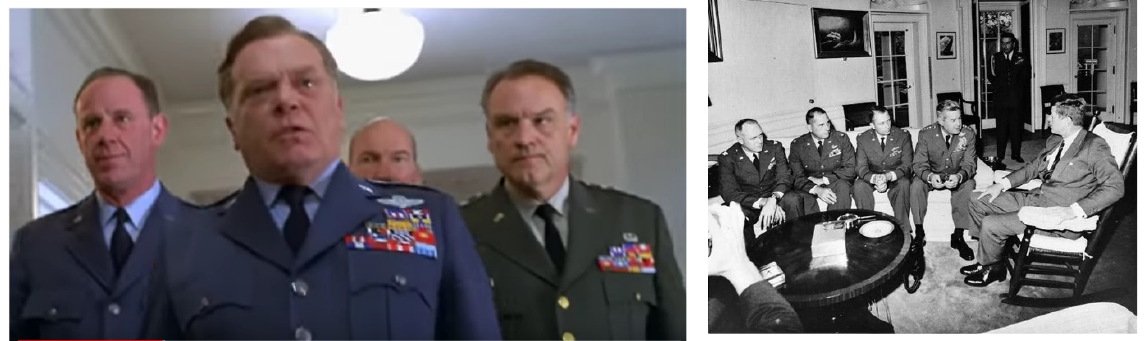
Figure 6: Clashing of Ideas Figure 7: Actual